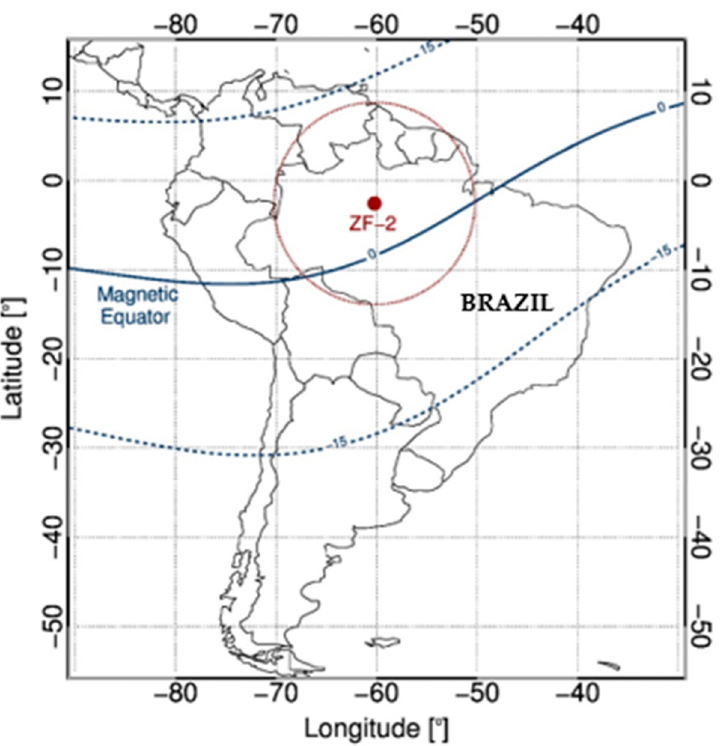
Figure 1. Location of the all-sky imager at ZF-2 (Amazon region) with its respective field of view, considering the OI 630 nm emission height at 250 km. Other relevant information, such as the mag- netic equator, is shown in the figure.